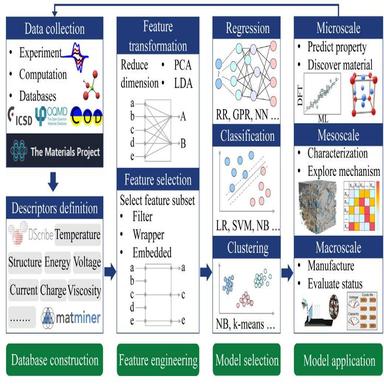
General application procedure of ML technology in MIB development.